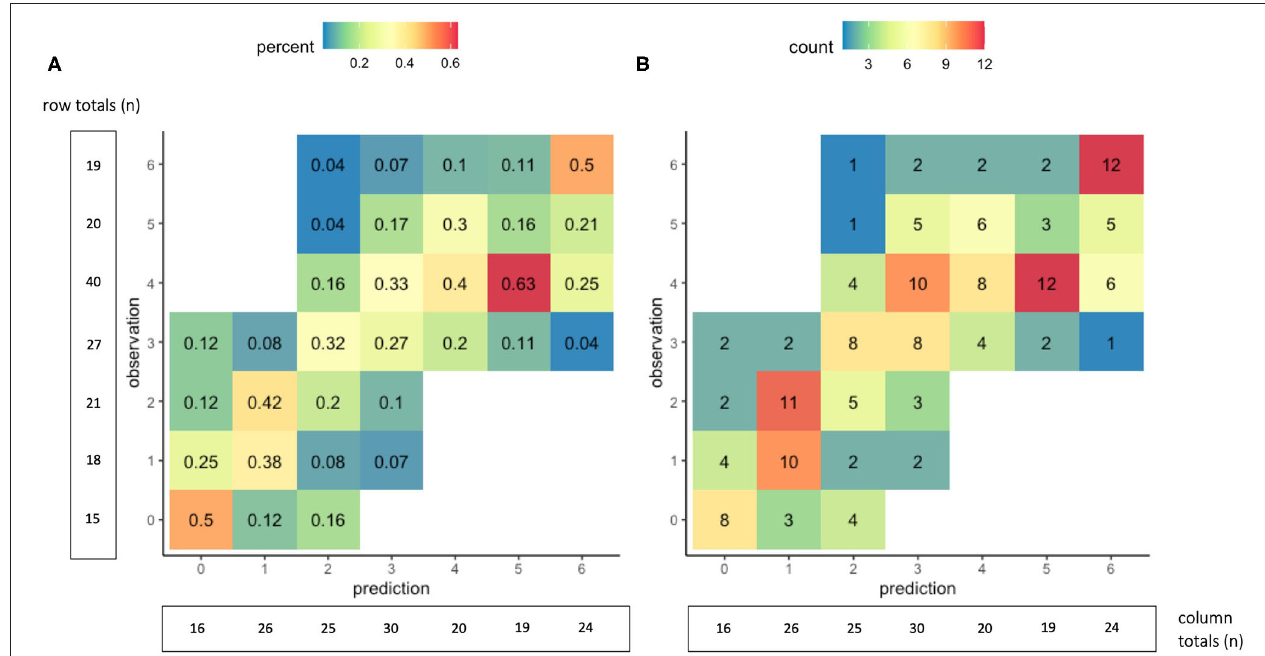
FIGURE 1 | Accuracy of the 90-day mRS prediction model in external validation. The graphs show cross-tabulations between the observed and predicted values of the 90-day mRS for the 160 patients in the external validation group. Values in graph (A) show proportions, where the columns represent the distribution of observed outcomes for a given predicted outcome. For example, of the 16 patients with a predicted mRS score of 0, the observed 90-day mRS score was 0 in 50%, one in 25%, two in 12.5%, and three in 12.5%. Values in graph (B) show counts of the observed and predicted mRS scores at 90 days.